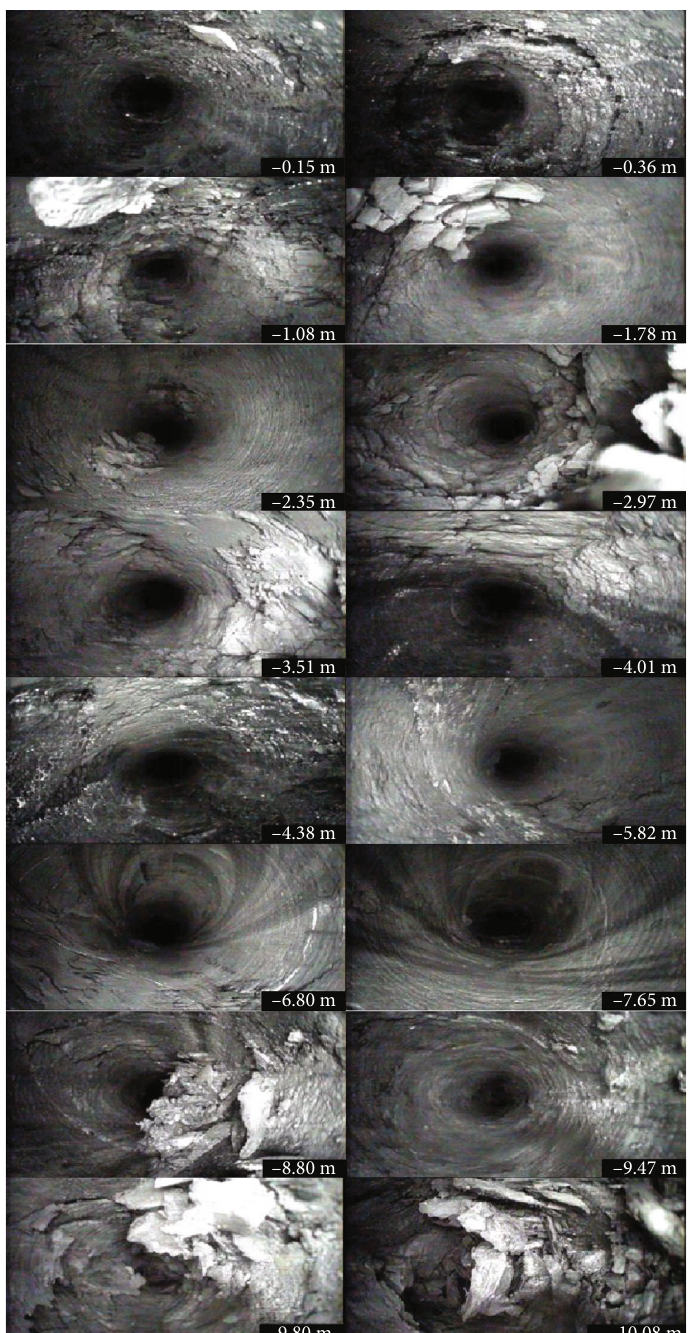
Figure 8: View of gas drainage boreholes in lower adjacent layer C 6c coal